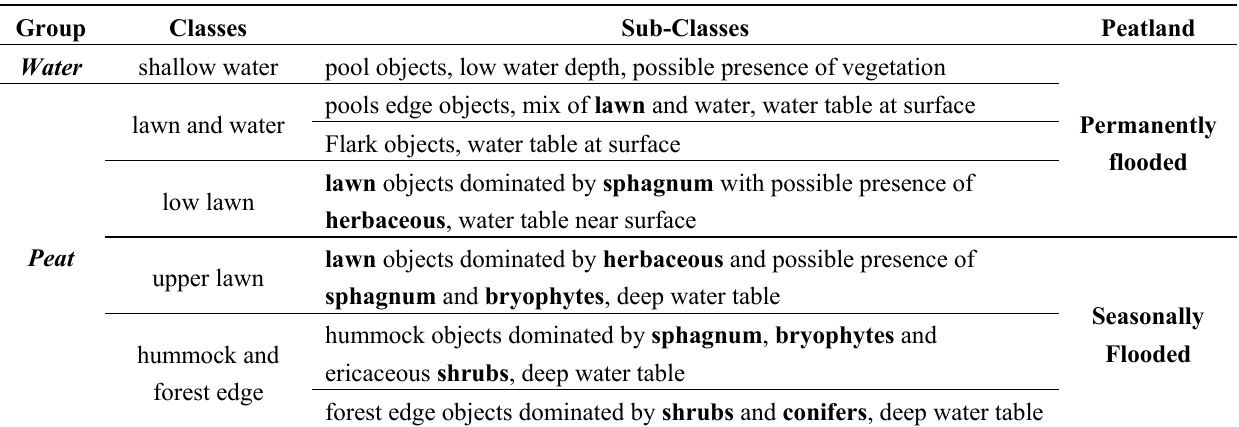
Table 7. Eco-hydrological hierarchical classification of boreal wetlands (adapted from [34]; lawn =